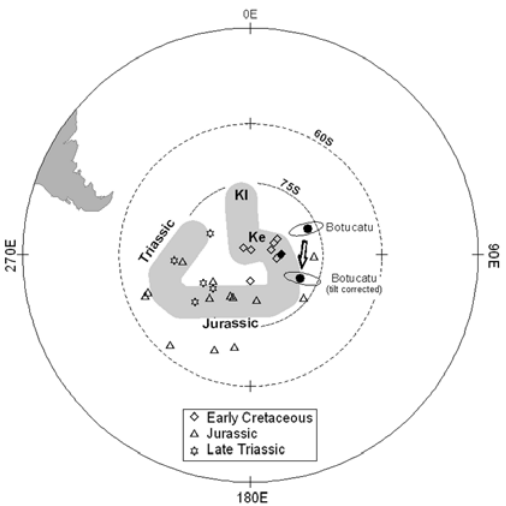
Fig. 10 – Comparison of the Botucatu poles (prior and after tilt correction) with the apparent polar wander path for South America during the Mesozoic, based on paleomagenetic poles compiled by Vizán et al. (2004), Iglesia Llanos et al. (2003) and Ernesto et al. (2002). For reference the Serra Geral pole is heightened (full